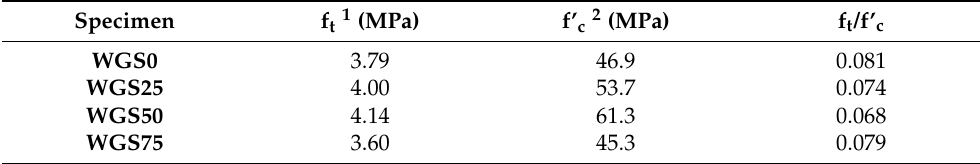
Table 3. The ratio between Split Tensile Strength and Compressive Strength. Specimen